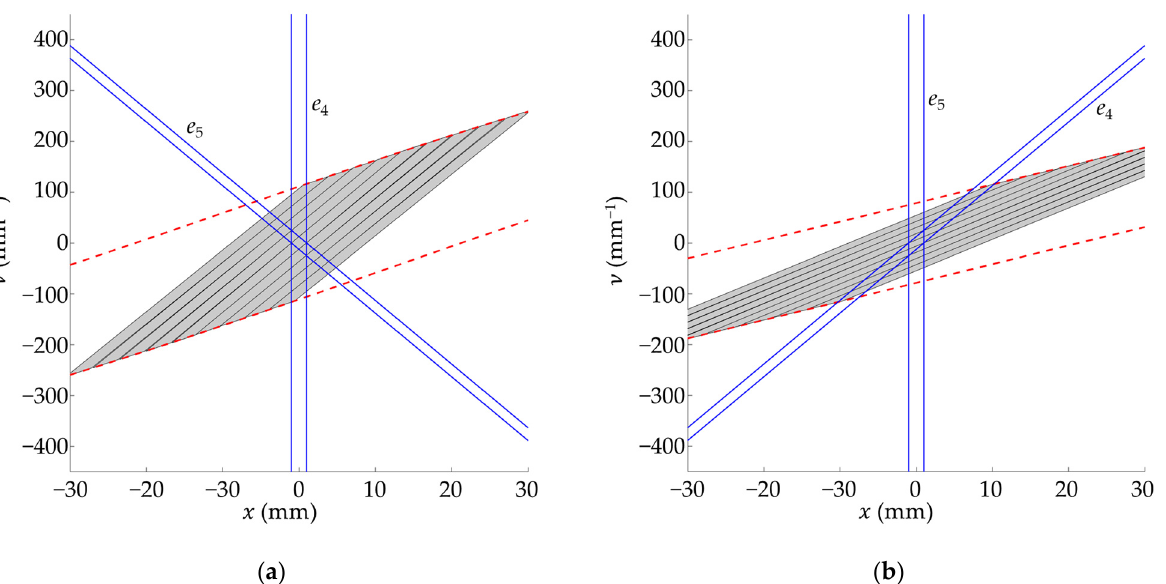
Figure 9. WDFs of the views at the fourth and fifth eye positions. ( a ) WDF at the fourth eye position; ( b ) WDF at the fifth eye position.